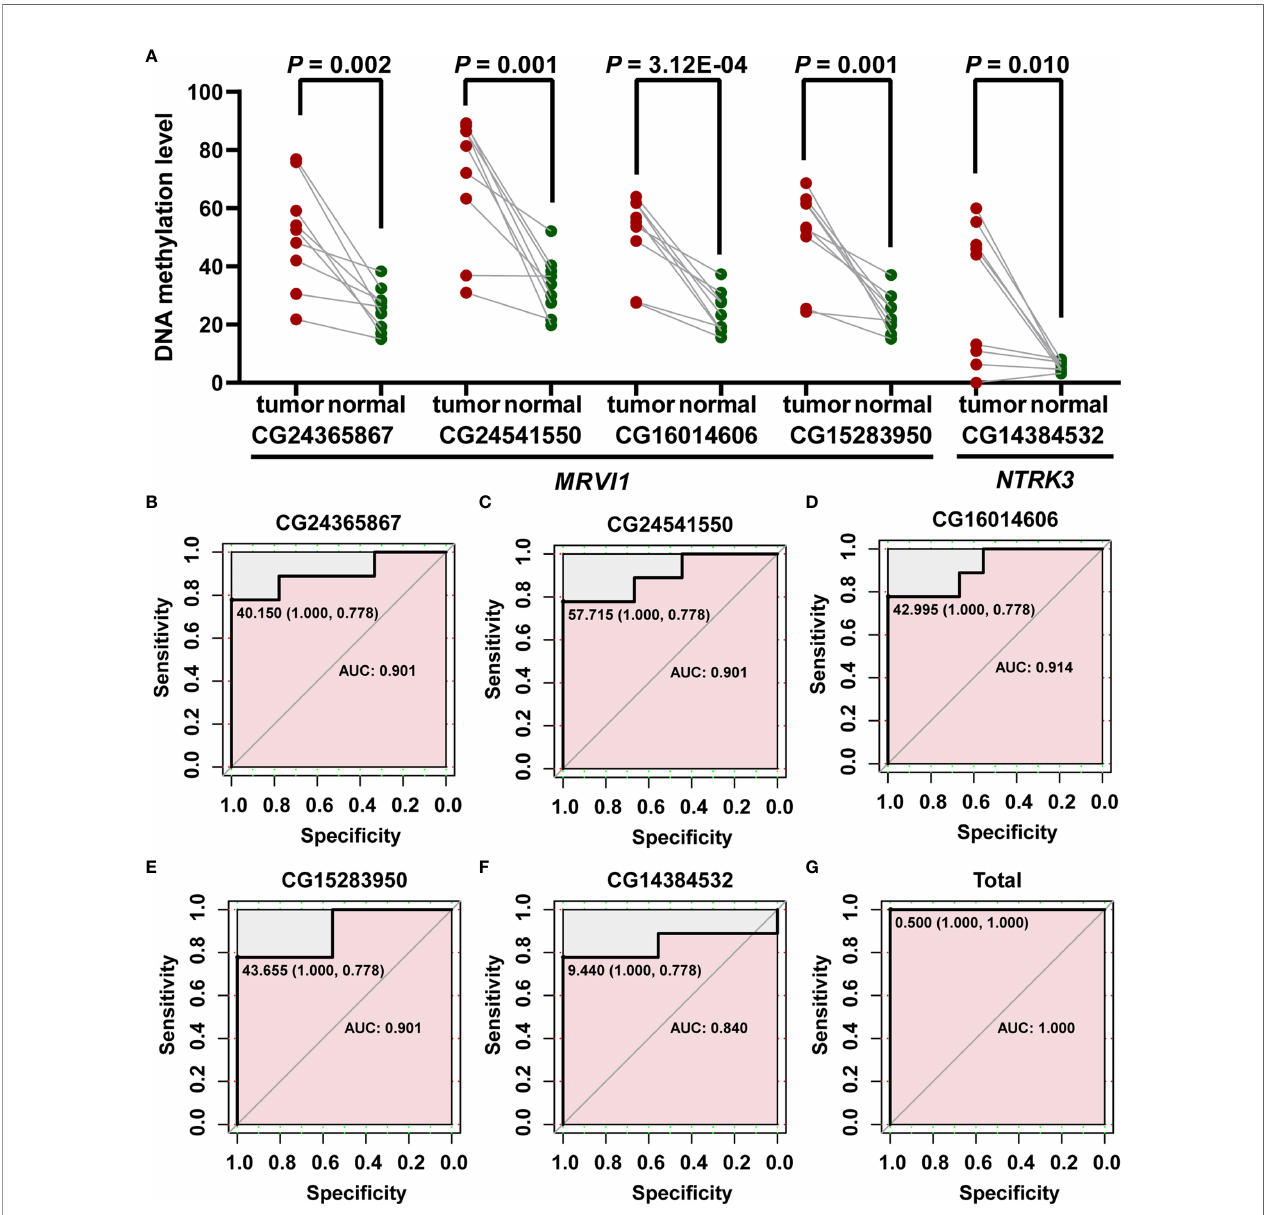
FIGURE 9 | Con fi rmed methylation levels and ROC curve analyses for the prediction of cervical cancer. (A) The methylation levels of MRVI1 and NTRK3 were signi fi cantly higher in cervical cancer tissues than in adjacent normal tissues. ROC curve of methylation levels of MRVI1 (B – E) , NTRK1 (F) , and combined methylation levels of fi ve CpGs (G) for distinguishing between cervical cancer and non-tumor cervical tissues. AUC, the area under the ROC curve; ROC, receiver operating